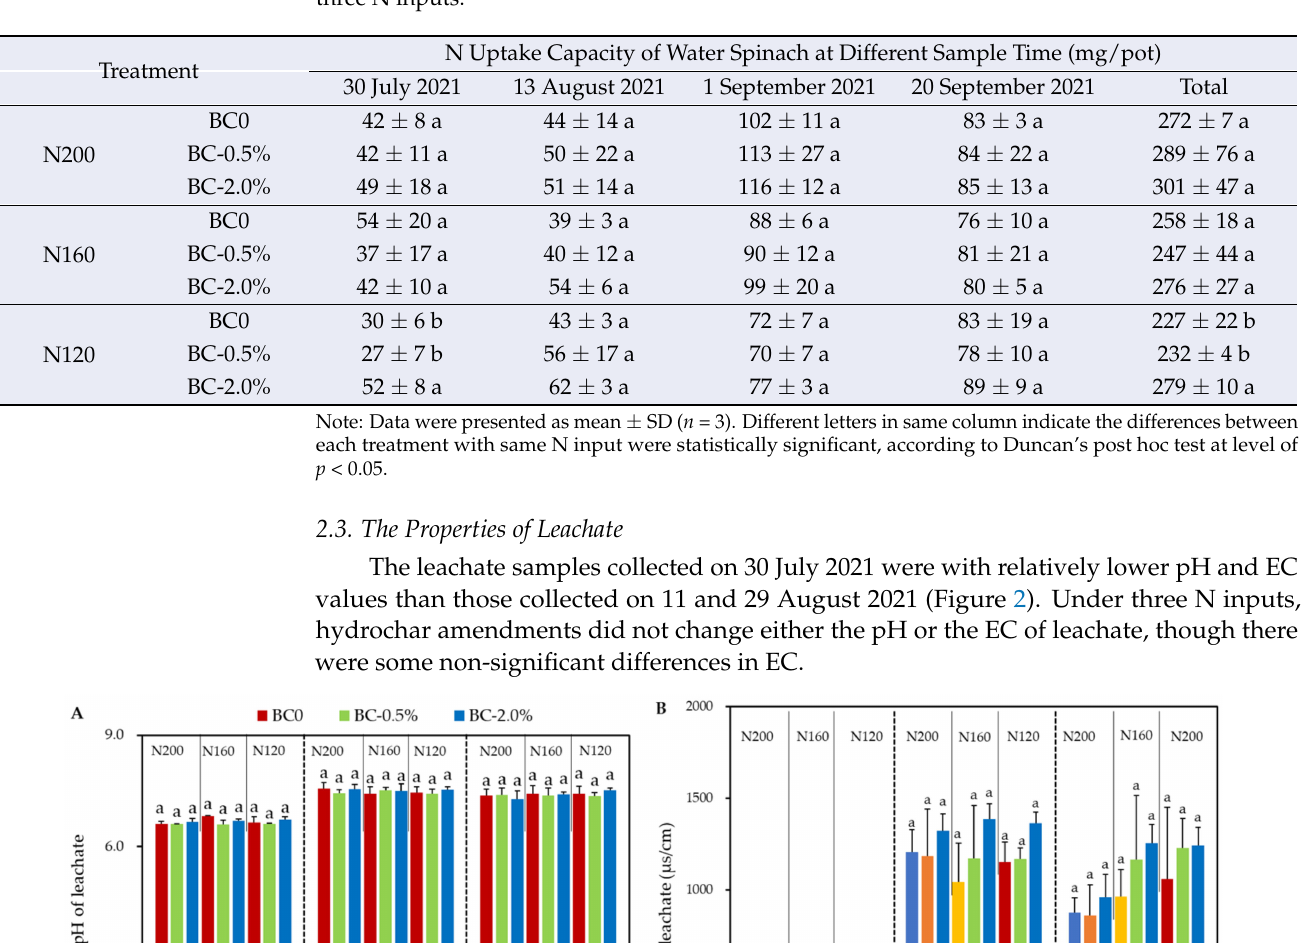
Table 2. Effects of hydrochar amendment at two rates on N uptake capacity of water spinach under three N inputs.